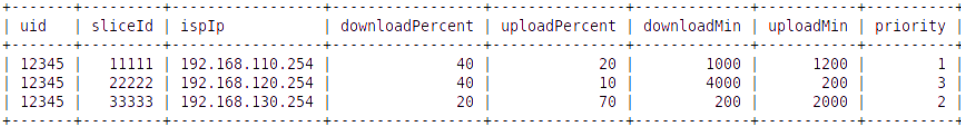
Figure 5. SQL database sample.